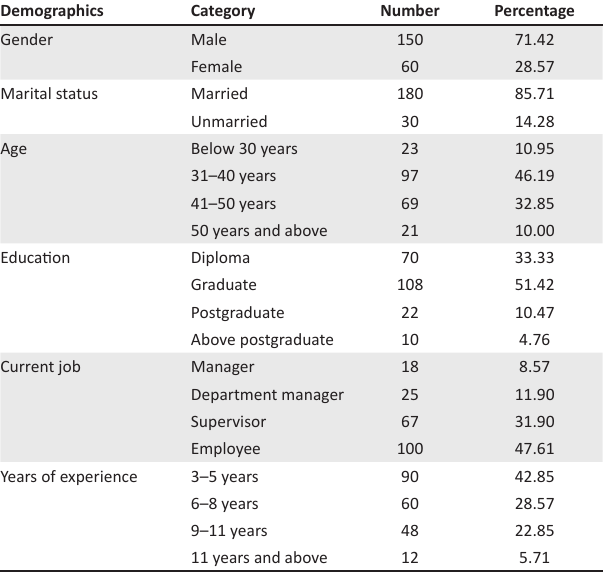
TABLE 1: Demographic profile of the respondents.